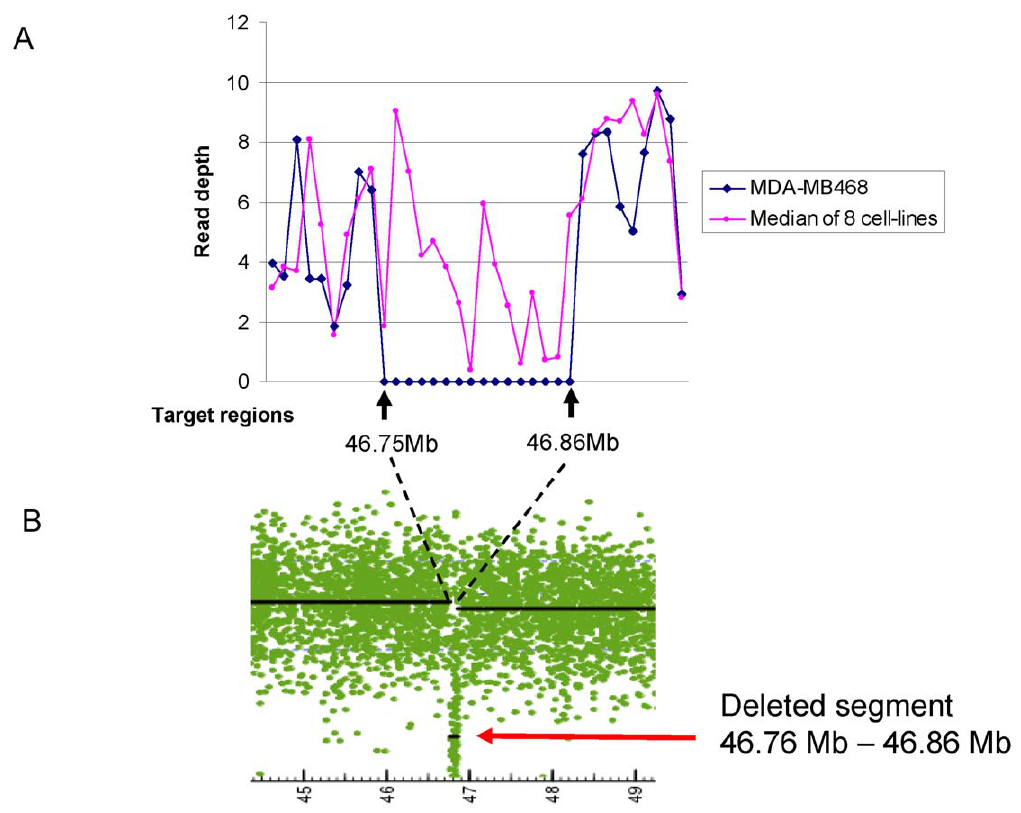
Figure 3. Sequencing read depth around the SMAD4 gene on chromosome 18 in the MDA-MB468 cell line. A . Plots of read depth data on consecutive exons around the SMAD4 gene region on chromosomal 18. The blue line shows sequencing read depth data for MDA-MB468, and the pink line shows the median sequencing read depth of all eight cell lines. B . Copy-number data from Affymetrix SNP6 chip data around the SMAD4 gene region on chromosomal 18. The black line shows the segmented copy-number data (log2 ratio to normal samples) generated by the aroma.affymetrx package in R as described in the methods section.